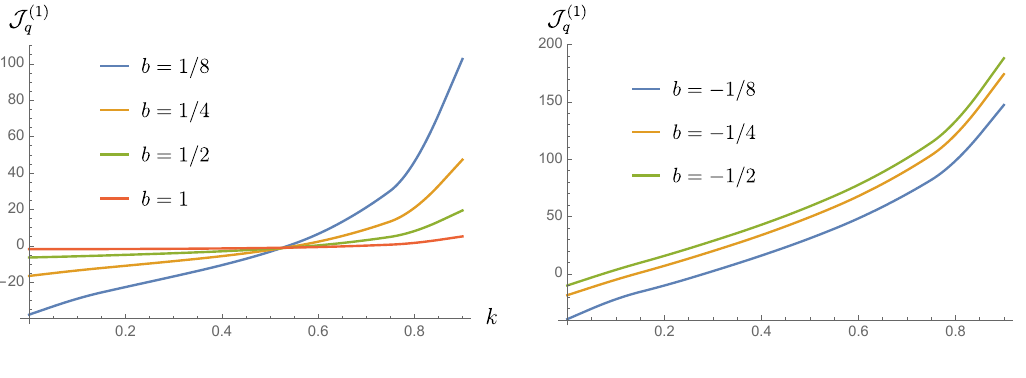
Figure 6. The results for the (cid:12)nite part of J 1